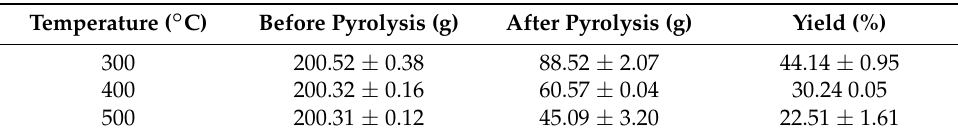
Table 5. Food waste compost biochar